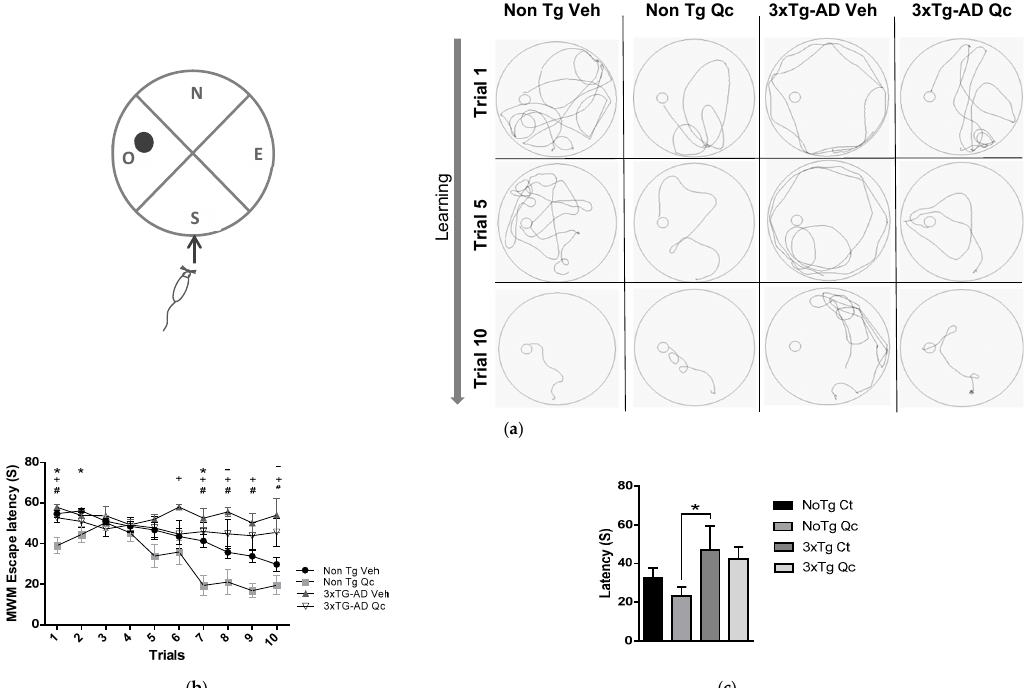
Figure 3. Effect of quercetin oral administration on the spatial learning test in 3xTg-AD mice . ( A ) Representative images of the trajectory in the MWM in one of the four positions in trials 1, 5, and 10. ( B ) Exhaust latency in the spatial learning test. ( C ) Latency of passing through the platform in the learning retention test. The time is expressed in seconds. Data are represented as the mean ± SEM. n = 8-19. * p : < 0.05; ** p : < 0.01; *** p : 0.001. * Differences between non-Tg Veh and non-Tg Qc; - Differences between non-Tg Veh and 3xTG-AD Veh; + Differences between non-Tg Qc and 3xTG-AD Veh; # Differences between non-Tg Qc and 3xTG-AD Qc.